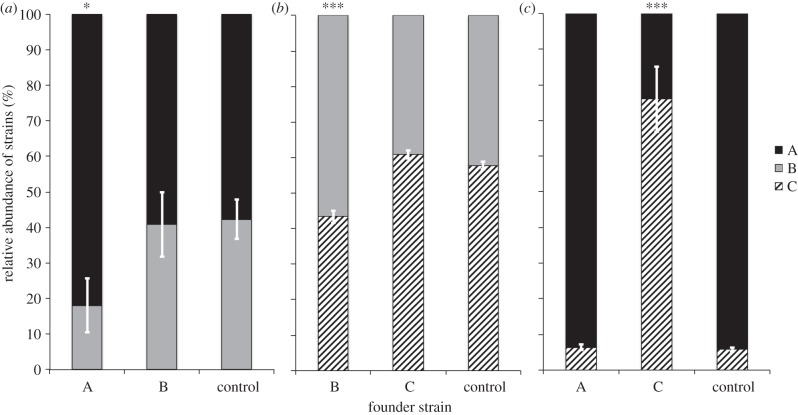
(a–c) Relative abundances of respective S. marinoi strains in mixed cultures determined by microsatellite marker peak-height ratios (AsQ-PCR). Founder strain grew for 3 days before invading strain was added. Reciprocal priority treatments and control between strain-pair: (a) A and B; (b) B and C; (c) A and C. Error bars indicate standard deviation of the mean (n = 3). Asterisks indicate significant differences in relative abundance compared with the control (*p < 0.05; ***p < 0.001).